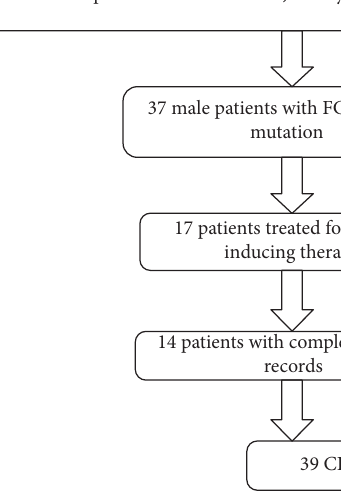
Figure 1: Flow chart of patient inclusion